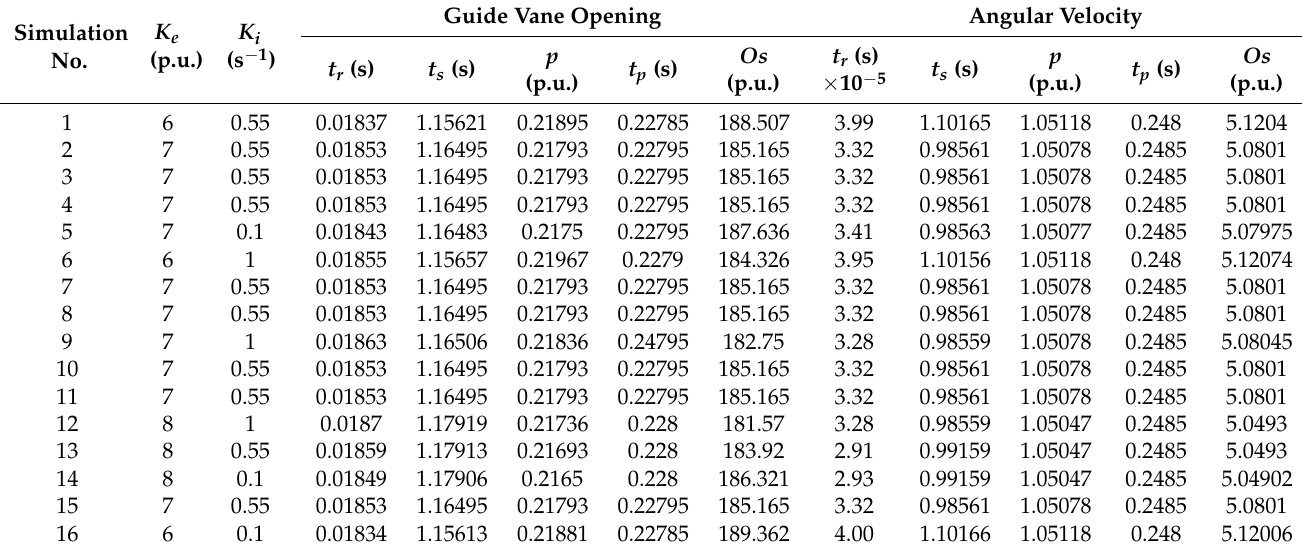
Table 5. The dynamic performance indexes of the guide vane opening and angular